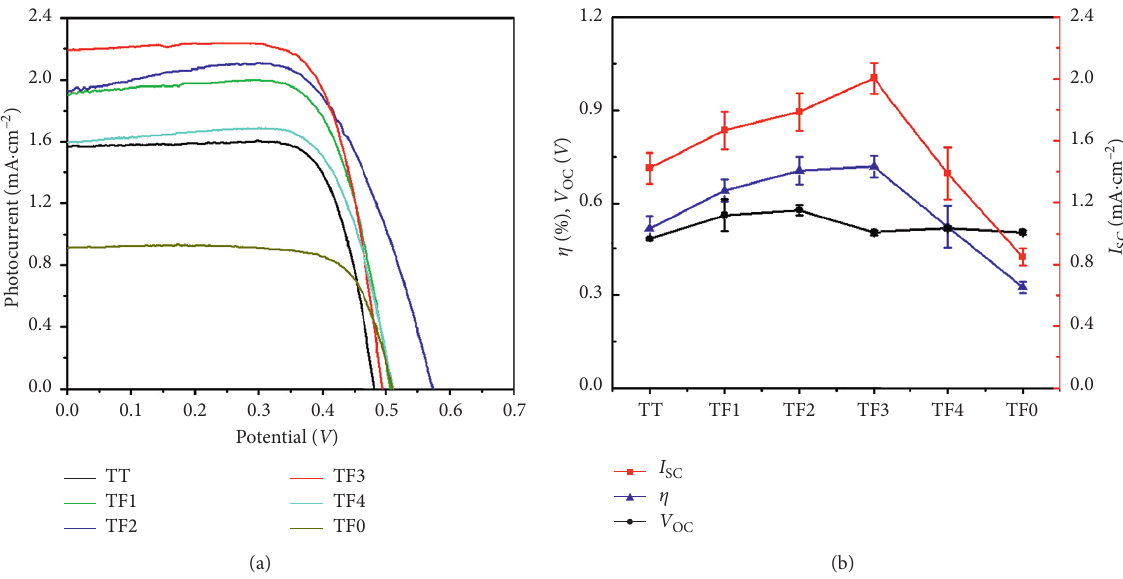
Figure 3: (a) I-V curves and (b) photoelectric parameters of TT, TF1, TF2, TF3, TF4, and TF0 film electrodes (standard deviation is stemmed from Table